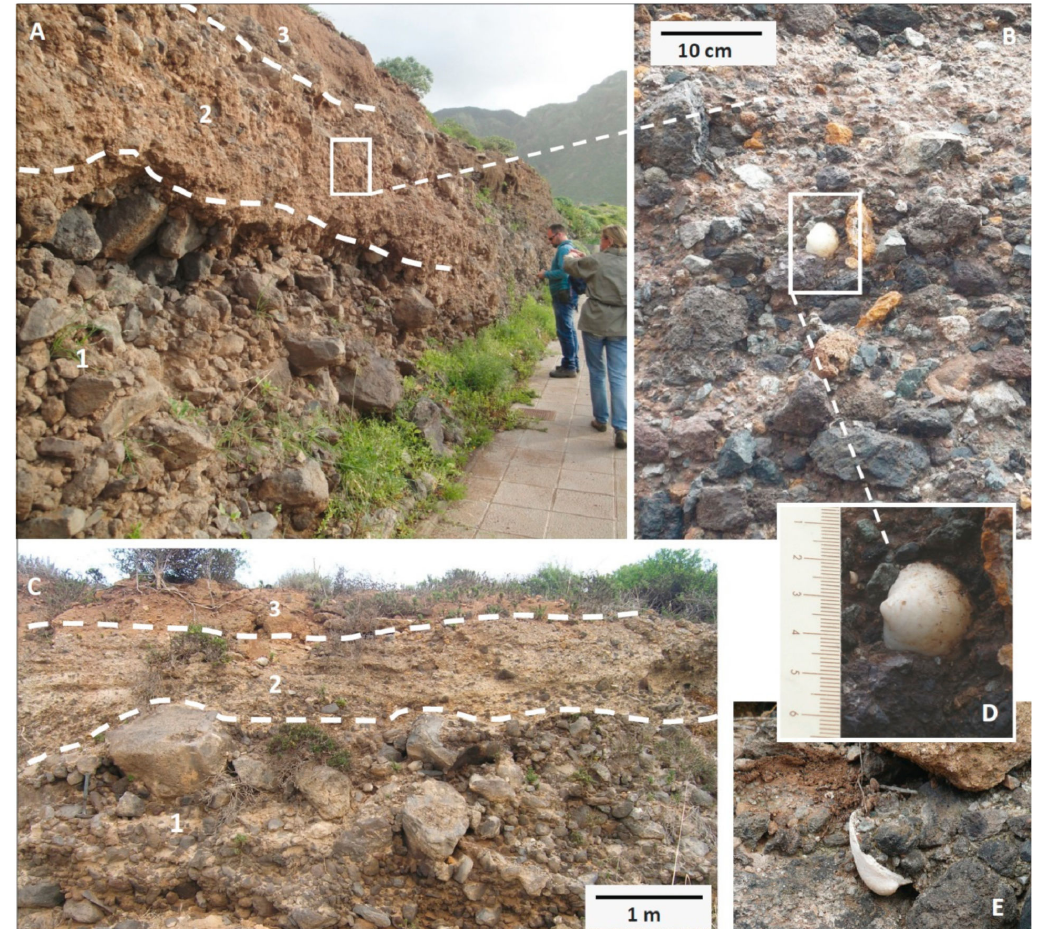
Figure 6. Playa de las Arenas site (Isla Baja). ( A , C ) Outcrops of the fossiliferous breccia with two well differentiated tsunami layers (1,2) contrasting in size and composition of detrital elements, fabric, and abundance of matrix, with crude reverse grading in the lower layer; an earthy colluvium caps the tsunami layers (3). ( B ) Detail of the upper layer with angular poorly sorted clasts of heterolithic composition and marine fossils. ( D , E ) Fossils incorporated as clasts in the upper